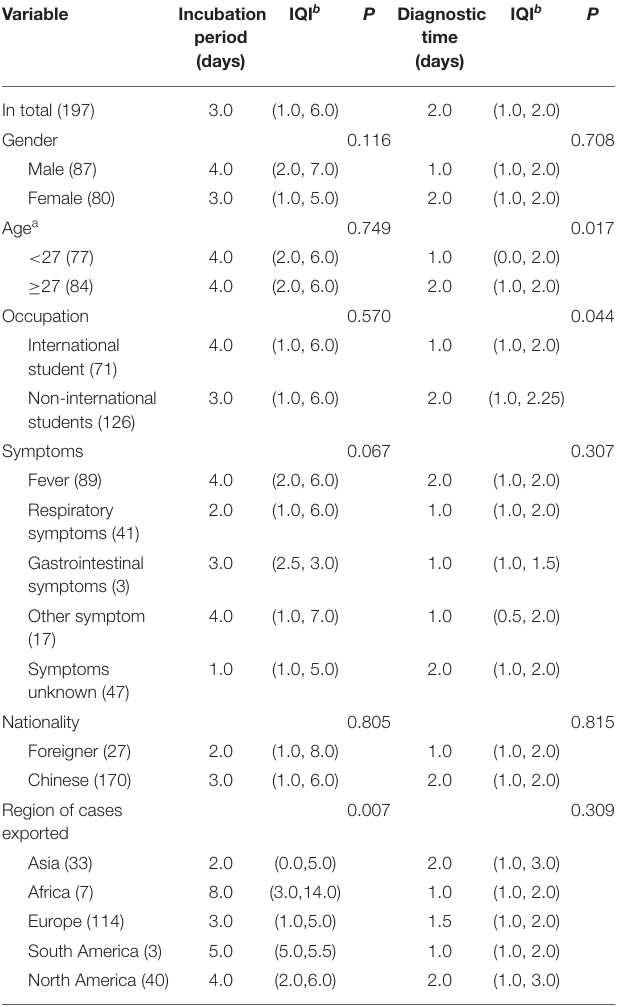
TABLE 2 | Epidemiological characteristics of symptomatic patients imported from abroad.